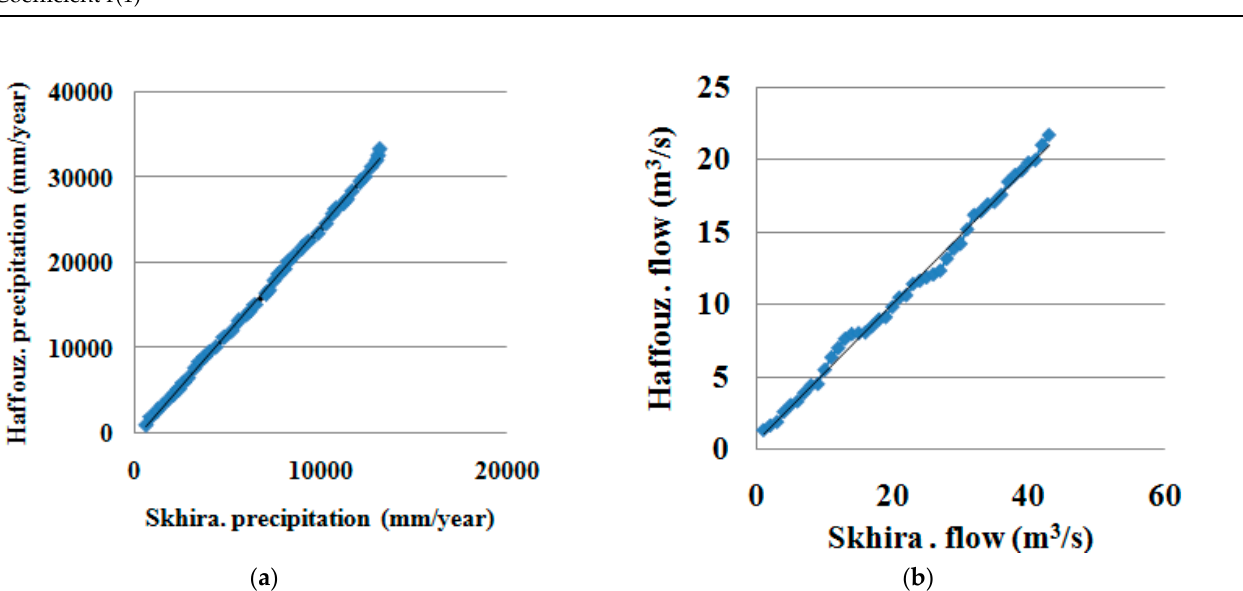
Figure 5. Double mass curves for, ( a ) precipitation, and ( b ) river flow . To analyze land use dynamics, we used multispectral Landsat 1, 5, and 8 satellite data. These images were used for calculation of NDVI index [49,50]. Landsat 1 MSS (Multi-Spectral Sensor) image was acquired for 21 July 1976, Landsat 5 TM (Thematic Mapper), and Landsat 8 OLI-TIRS (Operational Land Imager—Thermal Infrared Sensor) were for 19 July 1996 and 21 July 2016, respectively. The images have a spatial resolution of 30 m. All images were from July. This date coincides with start of the dry season and end of the rainy season. This made it possible to avoid effects of annual vegetation and to